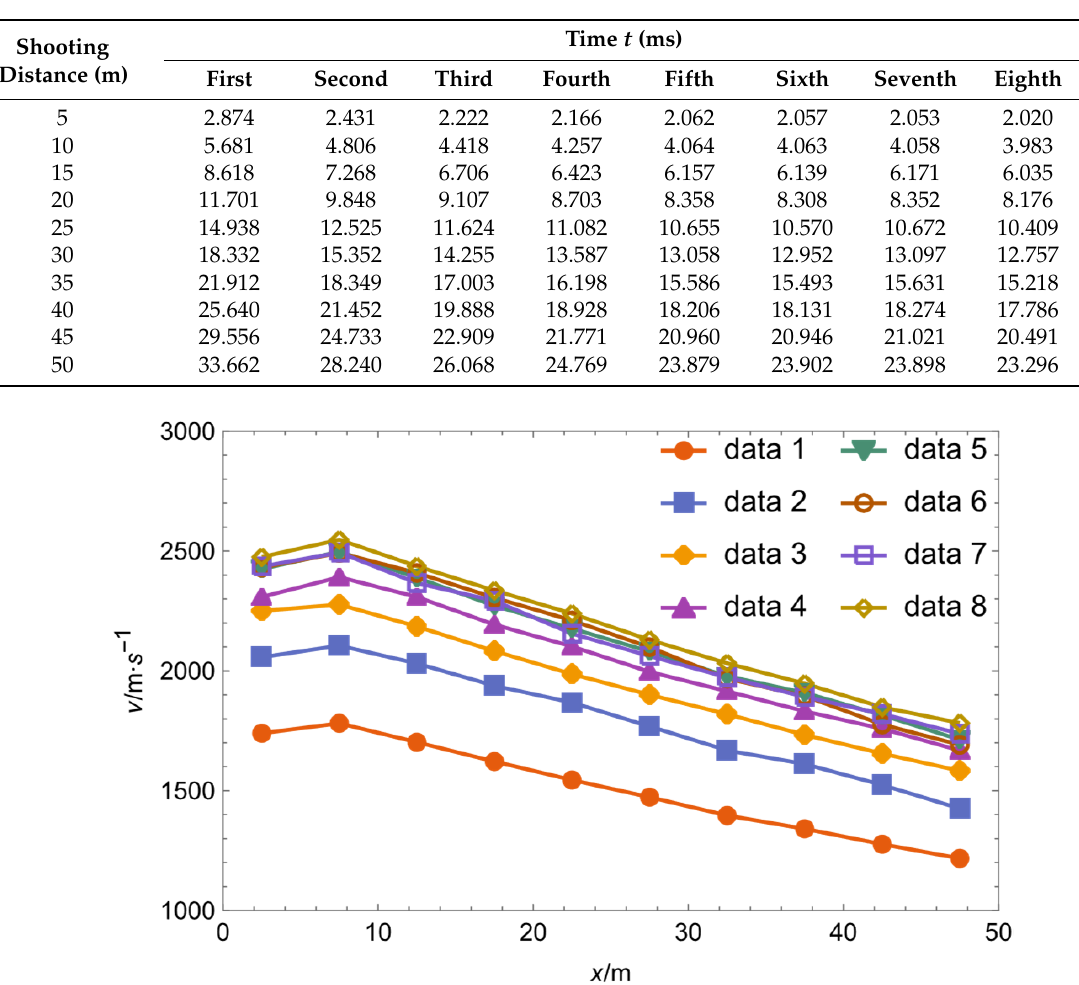
Figure 5. Velocity–displacement relationship at the midpoint of two targets.